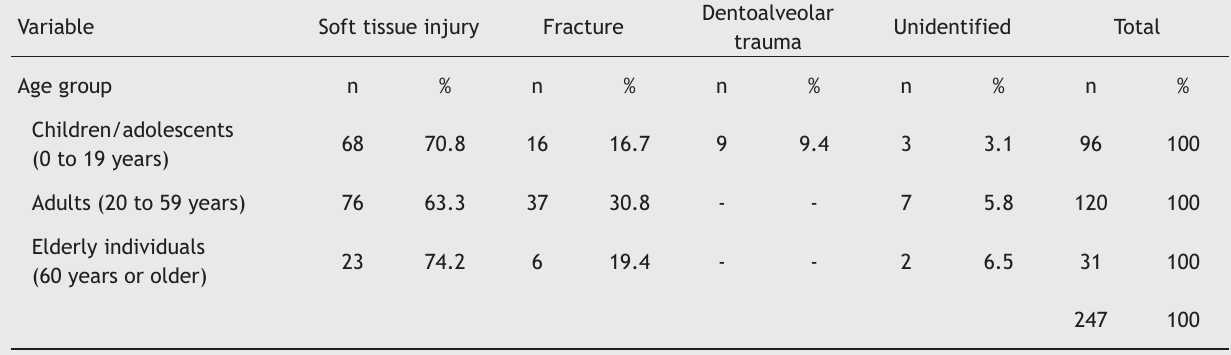
Table 4 Distribution of age groups according to type of injury: Campina Grande, Brazil, 2012 (n = 247).